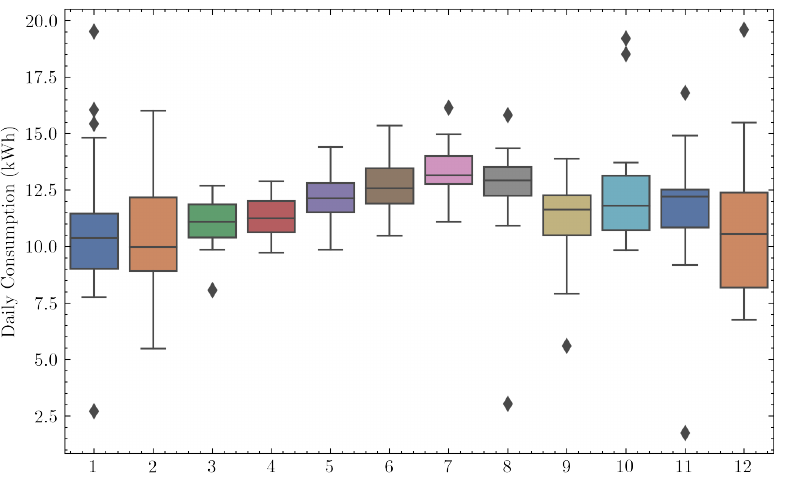
Figure 5. Box plot of the daily consumption for each month for one of the